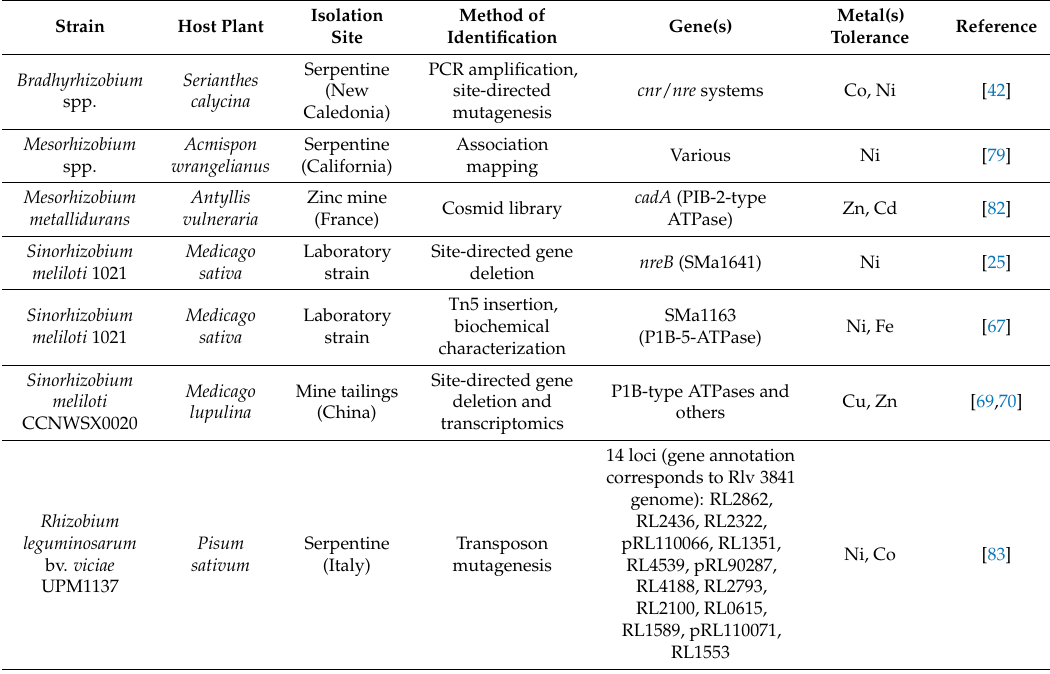
Table 2. Genes for heavy-metal (and metalloid) tolerance in symbiotic rhizobia. A summary of the main genes whose function in tolerance was confirmed experimentally is